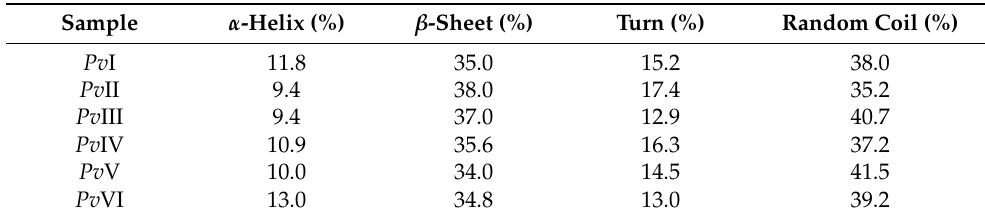
Table 5. The result of predicted secondary structure in purified protease.